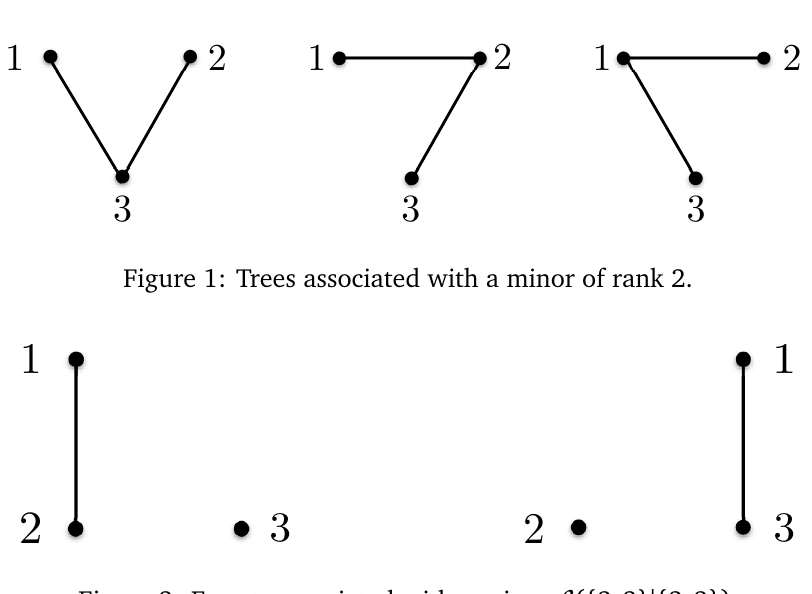
Figure 2: Forests associated with a minor L ( { 2,3 }|{ 2,3 } )